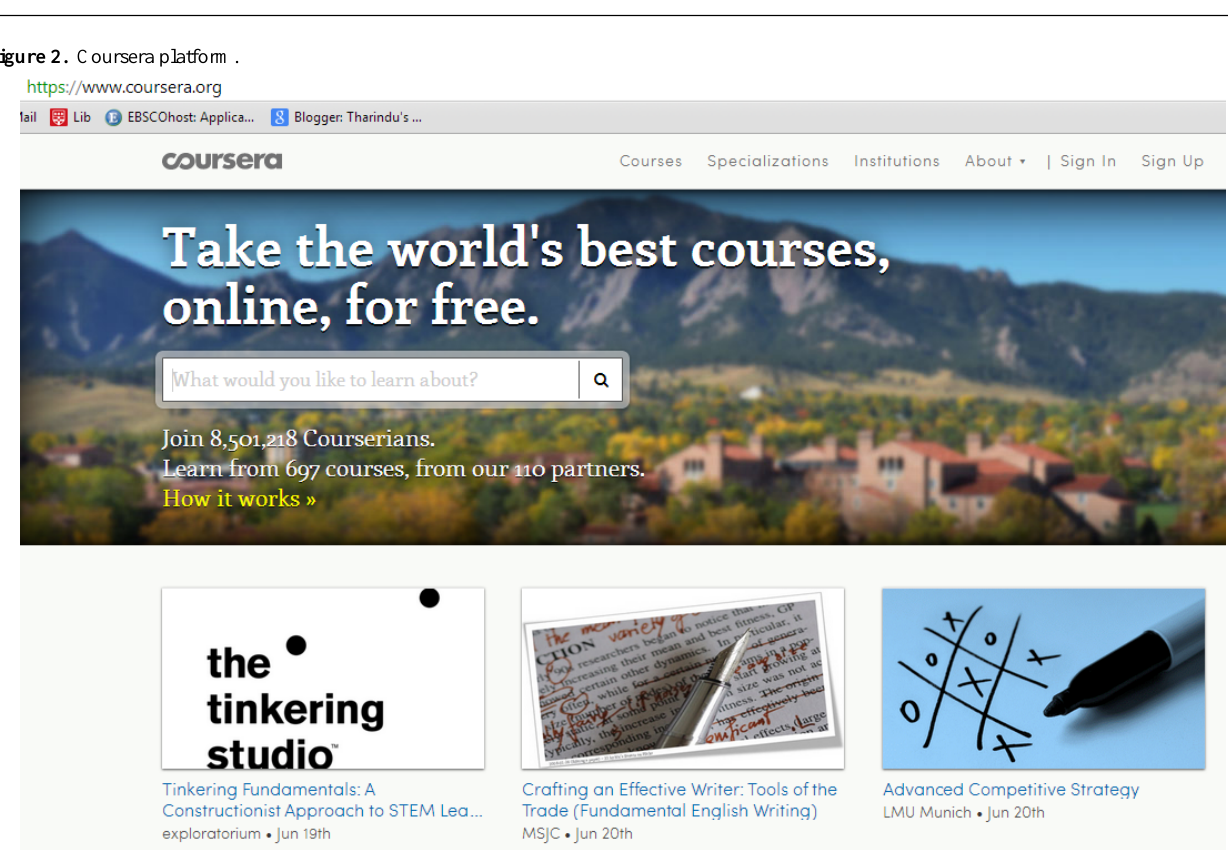
Figure 2. Coursera